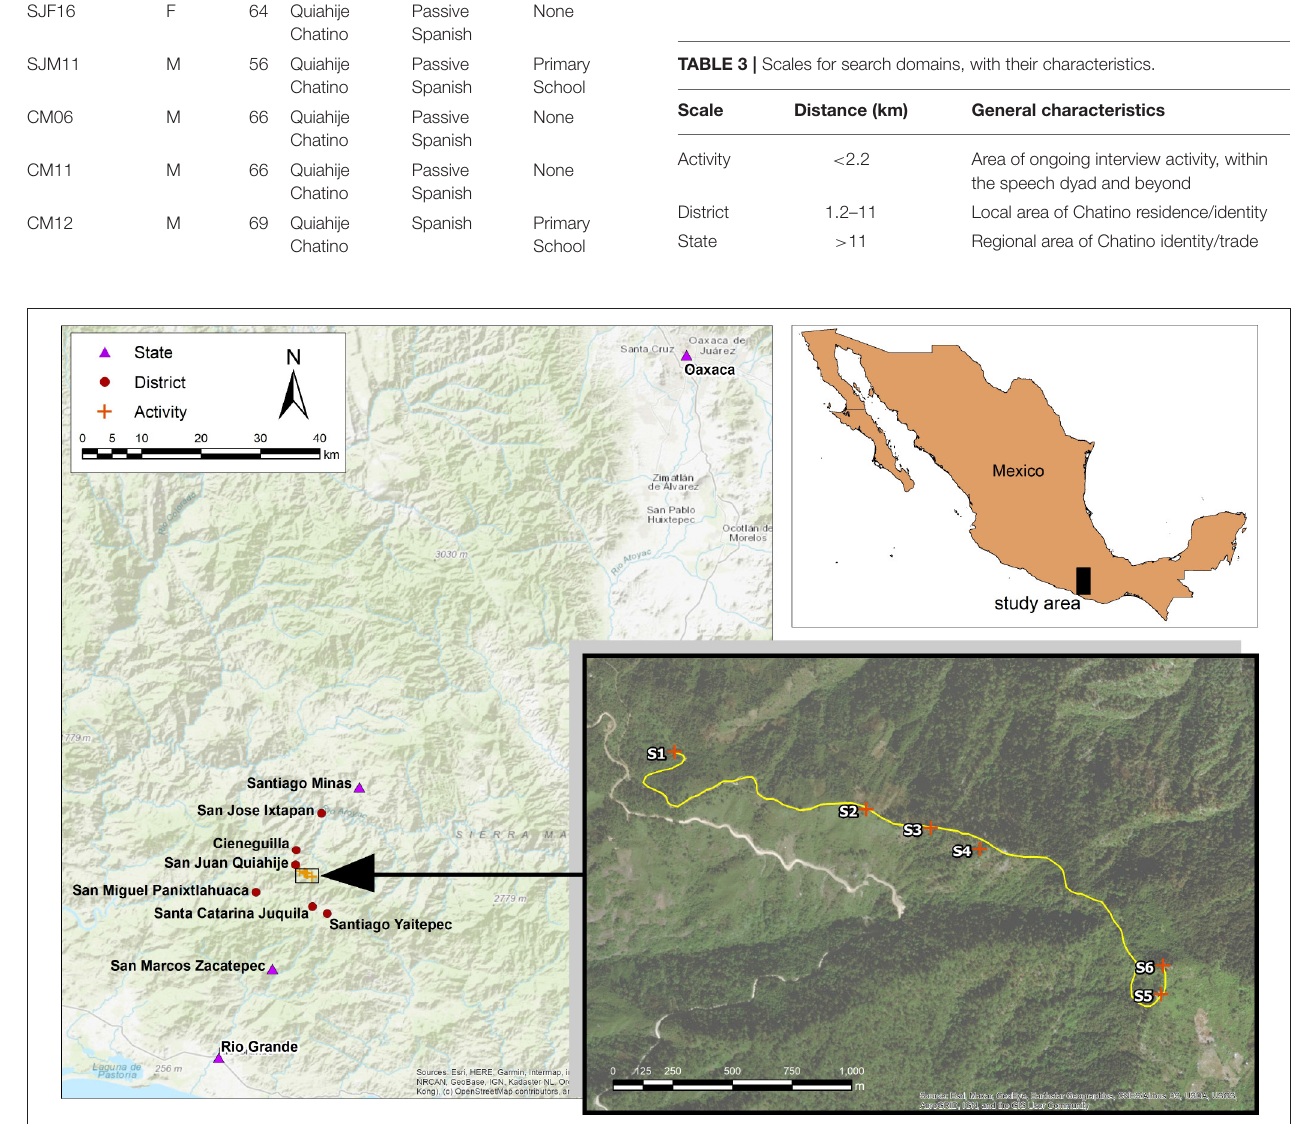
Frontiers in Psychology |